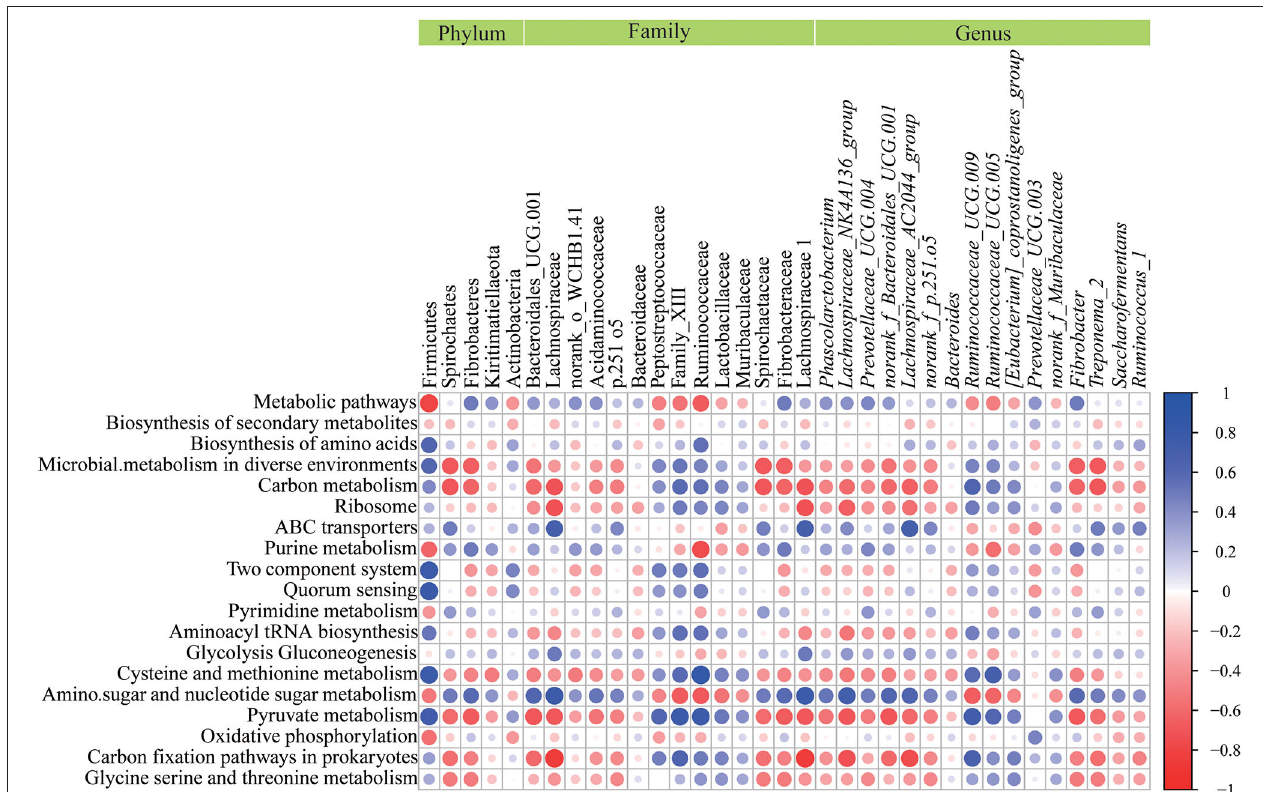
FIGURE 6 | Correlation analysis between microorganisms and metabolic pathways affected by seasonal changes. In the graph, each line describes a metabolic pathway, and each column describes a phyla, family, or genus. Each circle represents the Pearson coefficient between a microorganism and a metabolic pathway. Blue represents positive correlation, while red represents negative